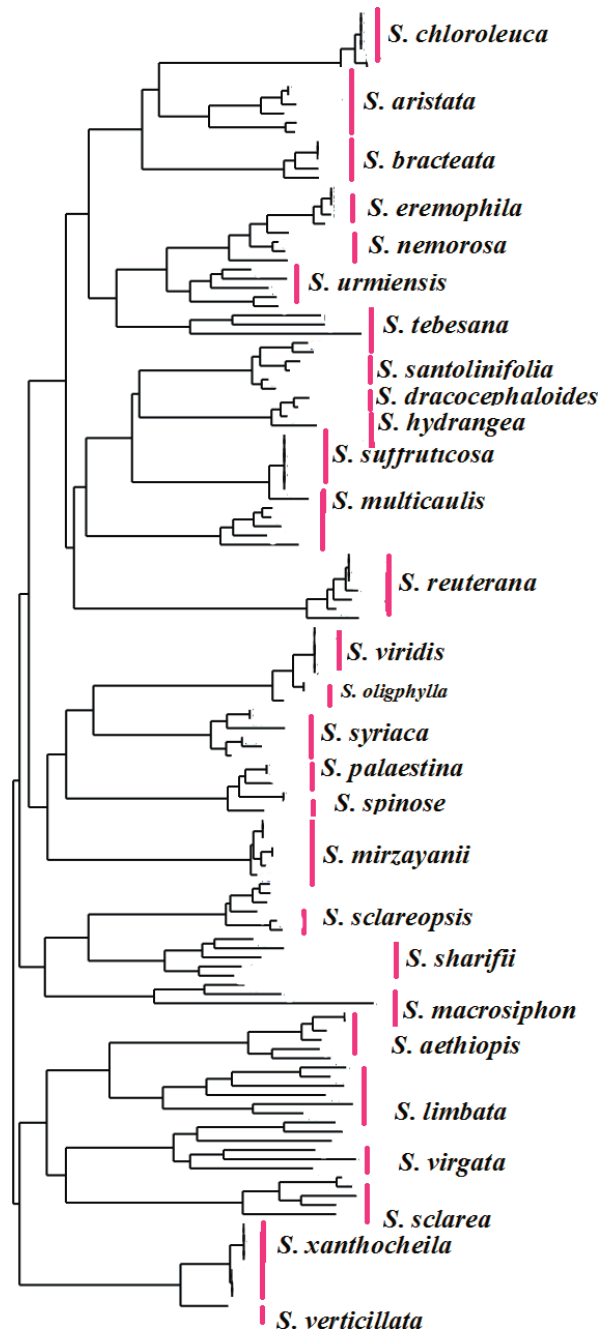
Figure 4. NJ tree of RAPD data revealing species delimitation in the